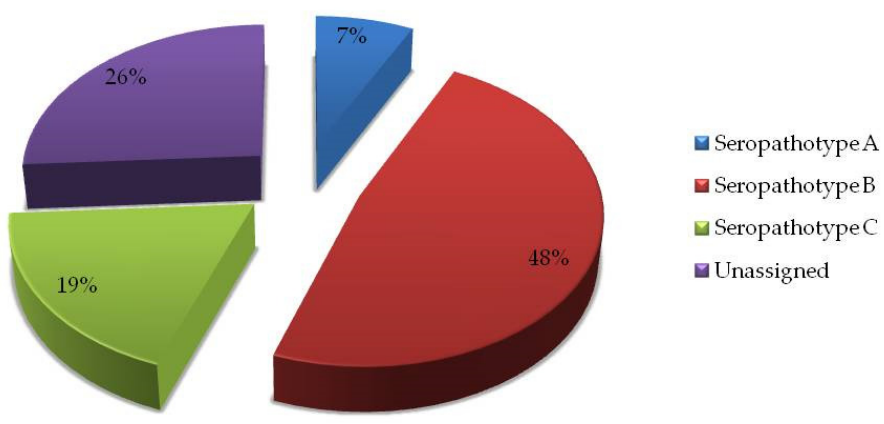
Figure 3. Distribution of seropathotypes (SPT) of isolated STEC from feed during the nine-year period ( n = 27 strains): SPT A: n = 2; SPT B: n = 13; SPT C: n = 5; Unassigned: not fully typed ( n = 7), seropathotypes are defined by Karmali et al. [27].